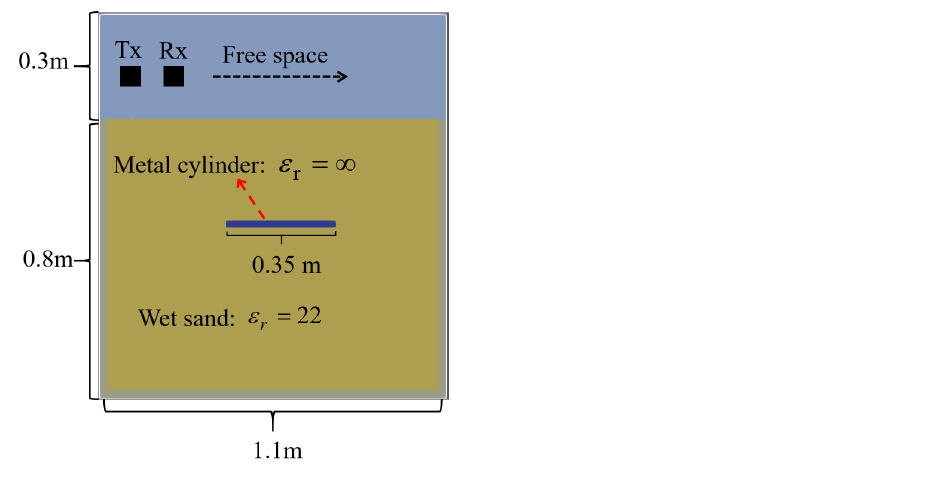
Figure 9. The model of simulations, including the transmitted antenna and received antenna, free space, metal cylinder, and wet sand.